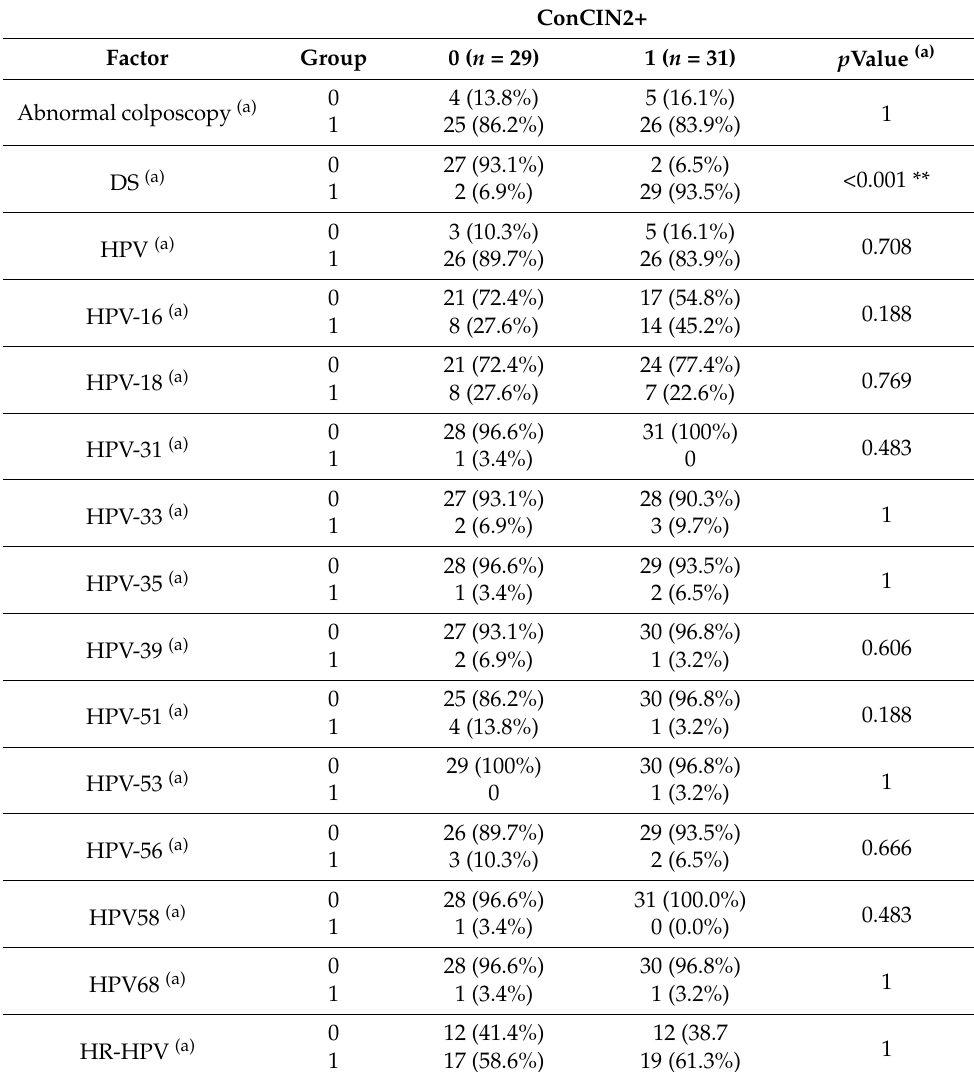
Table 3. Crosstabulation of CIN2+ and Colposcopy, Dual-Staining, HPV and HR-HPV, ASC-US, L-SIL, co-infection, and dual-staining on the conization piece. (a). Crosstabulation of CIN2+ and Colposcopy, Dual-Staining p16/Ki-67, HPV, and HR-HPV (Total Number and Separate for Each